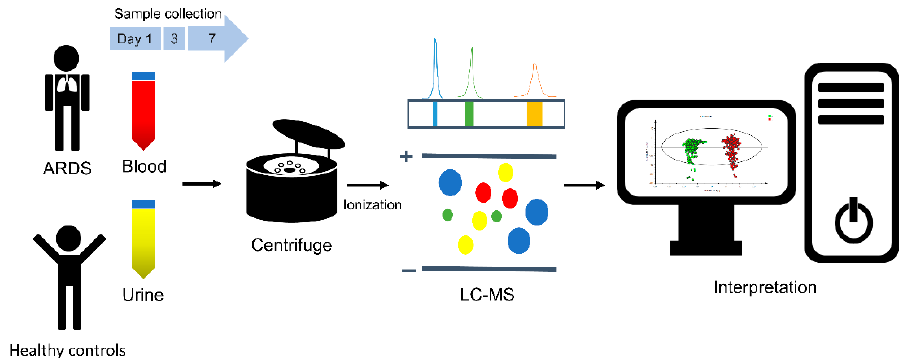
Figure 1. Schematic illustration showing the workflow of the study, involving the metabolomic analysis of biological samples from ARDS patients and healthy controls. Blood and urine samples were collected at day 1, day 3, and day 7 after ARDS onset. Blood and urine samples were also collected from healthy controls. Biological samples were analyzed for their metabolic profiles. ARDS: acute respiratory distress syndrome; LC-MS: liquid chromatography-mass